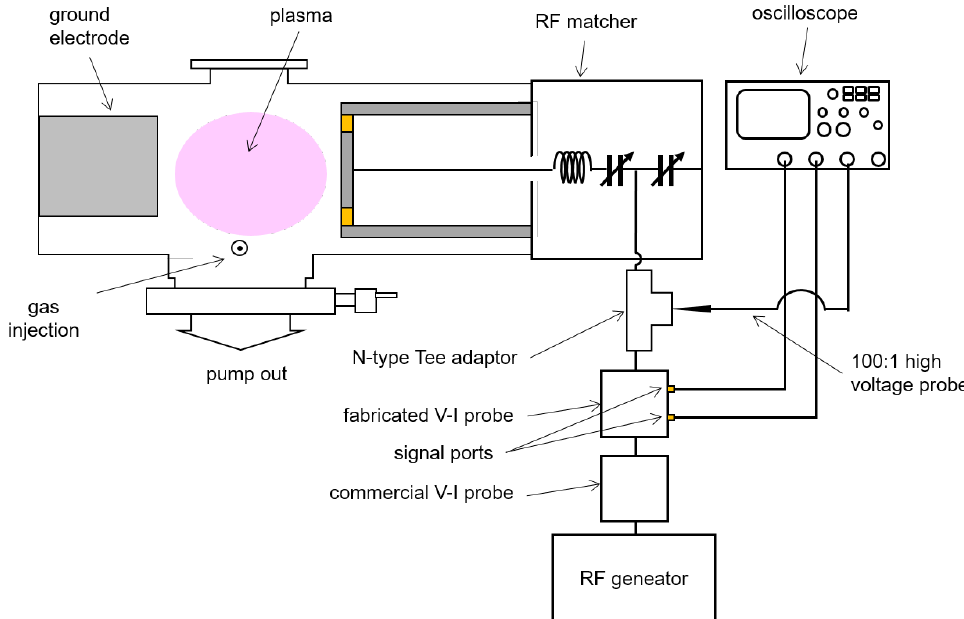
Figure 10. Experimental setup for a comparison of the fabricated VI probe with a commercial VI probe. A commercial VI probe is installed between the RF generator and the fabricated VI probe for the comparison. The RF generator applies power to the electrode and argon plasma is generated.